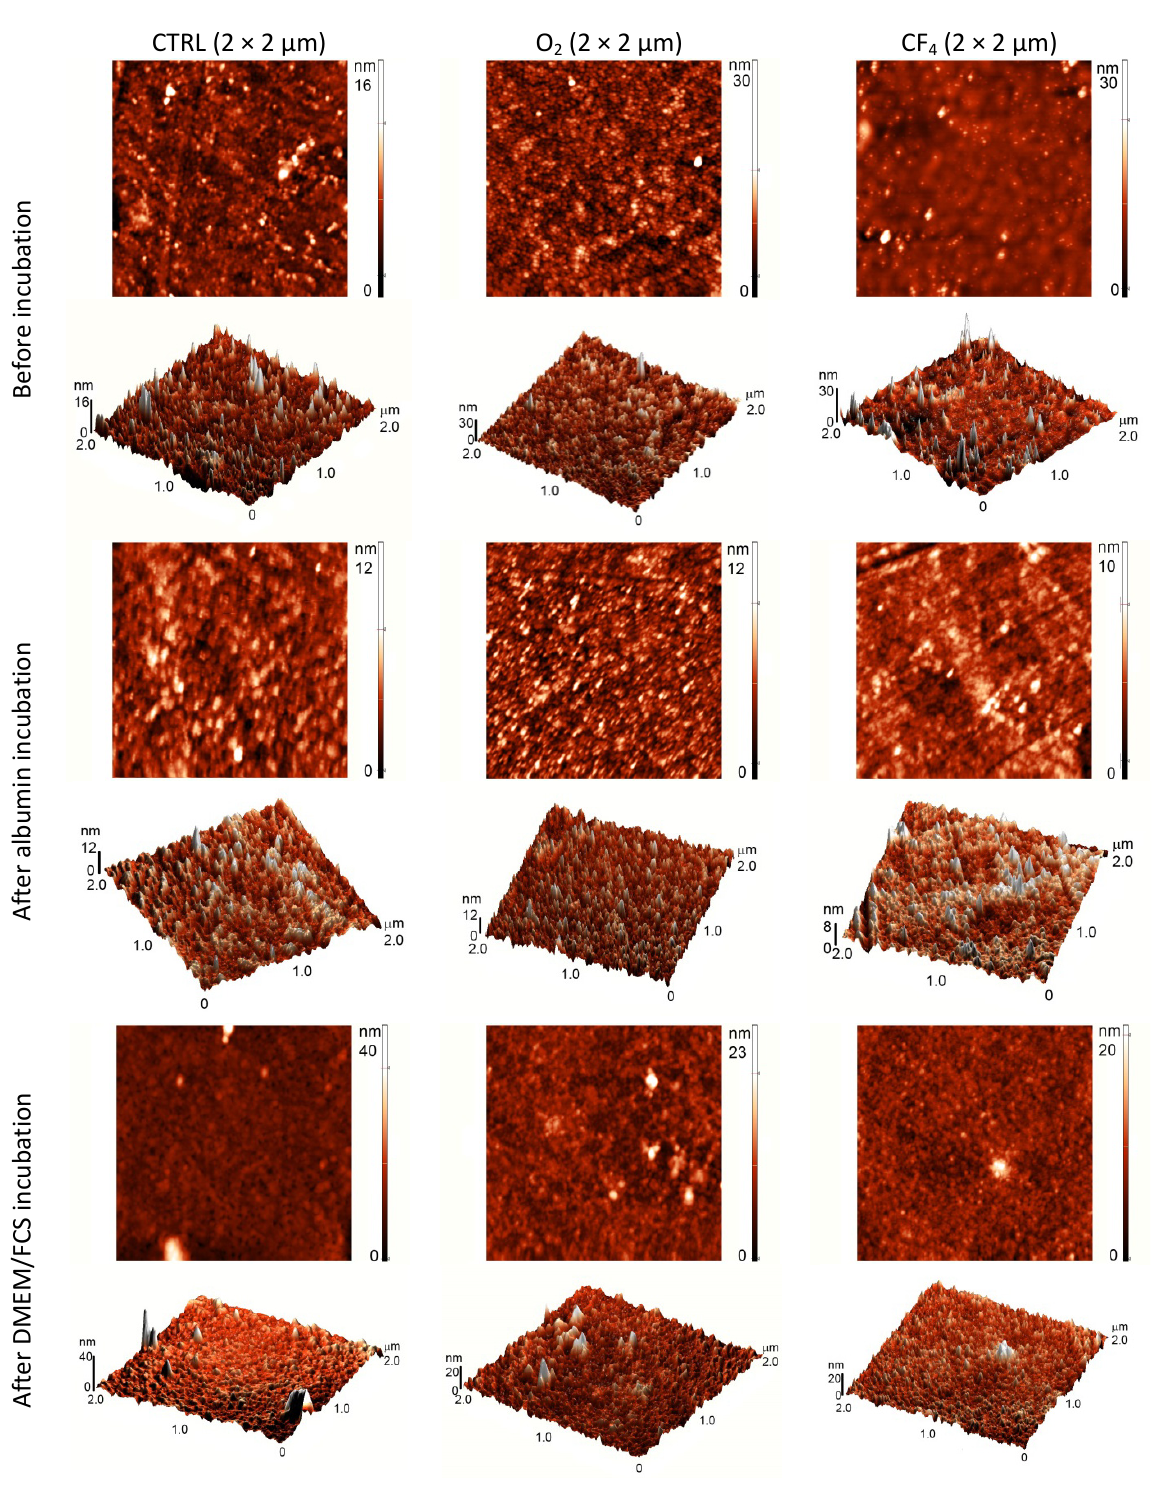
Figure 7. AFM images (2 × 2 µm) of different plasma-treated surfaces before and after incubation in a protein